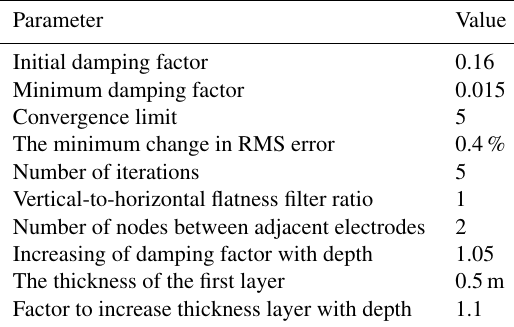
Table A5. Inversion parameters for ERT.